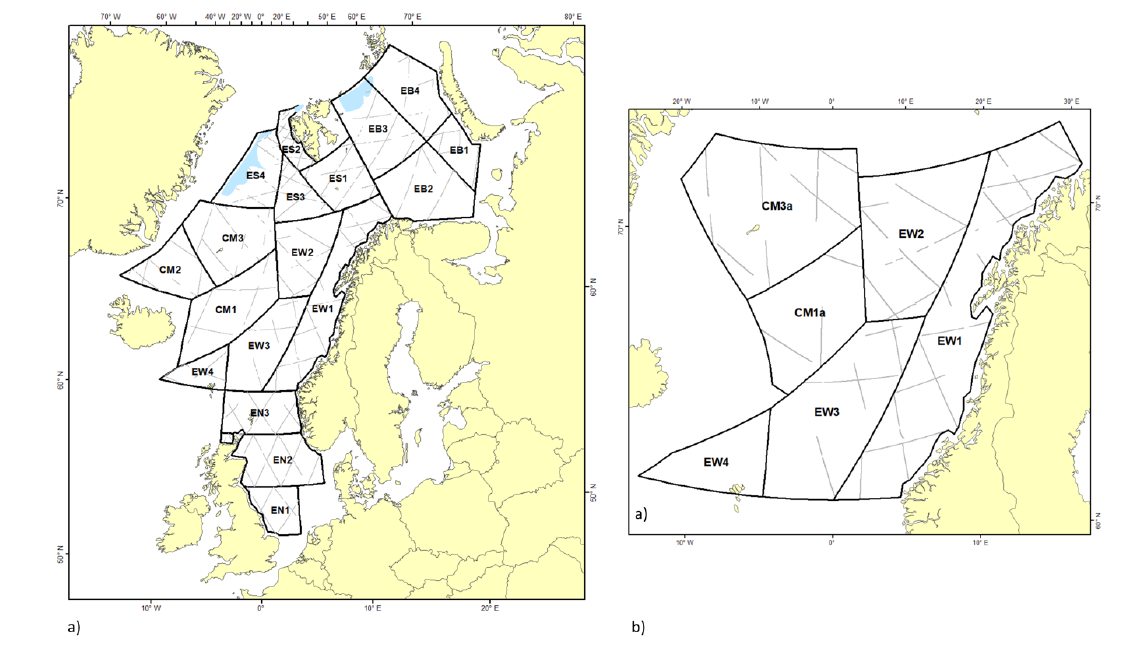
Figure 1. (a) Survey blocks (derived from minke whale SMAs) and realized search effort on predetermined transect lines during the 2014 – 2018 sighting surveys, with the blue areas representing ice coverage; (b) the 2015 NASS extension survey blocks and